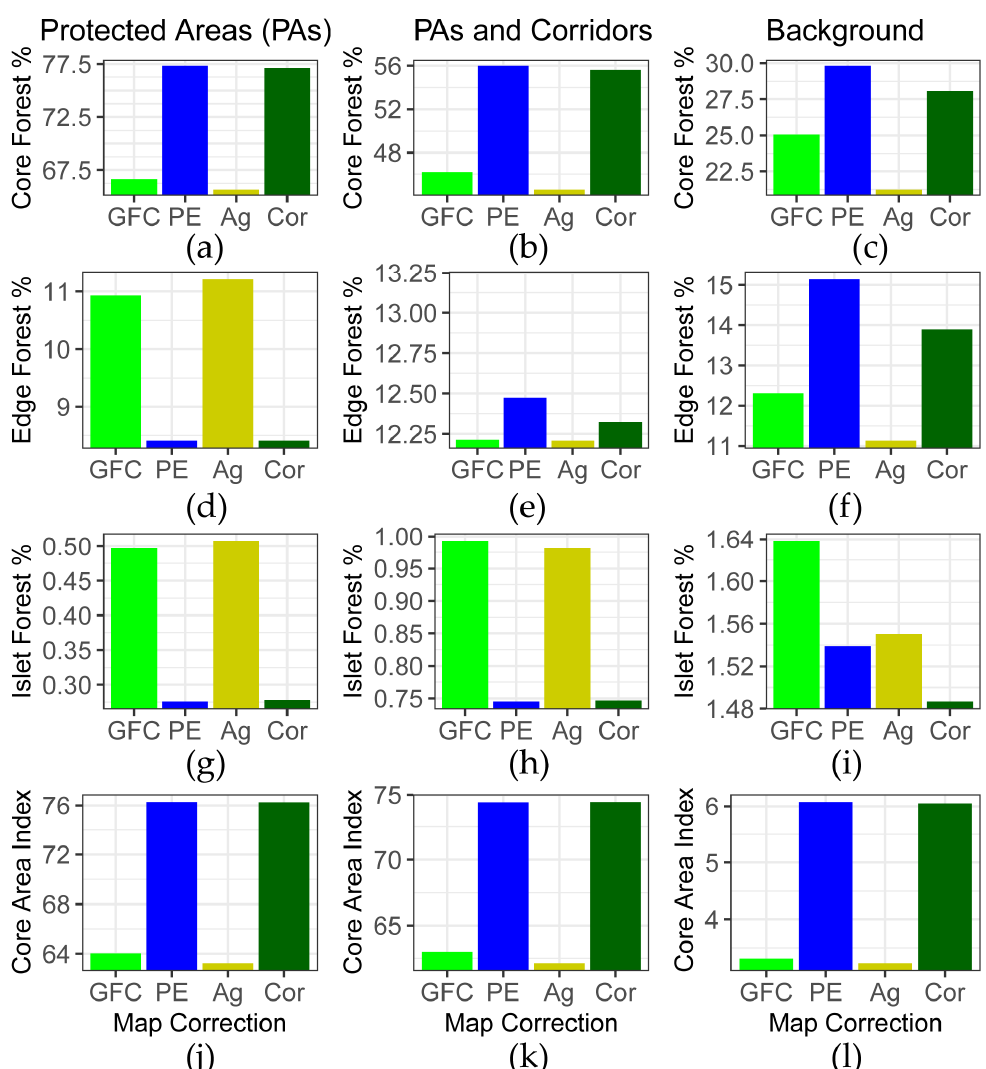
Figure 11. Changes arising from map corrections in four fragmentation metrics: core forest area (panels a – c ), edge forest area (panels d – f ), islet forest area (panels g – i ), and mean core area index (panels j – l ). Metrics are summarized across protected areas, protected areas and corridors together, and unprotected background areas. Note the differences in y-axis scales among plots. Map correction abbreviations: GFC = original 2015 GFC map; PE = GFC map only corrected for precipitation and elevation; Ag = GFC map only corrected for agriculture; Cor = Final revised GFC map, corrected for precipitation, elevation, and agriculture.